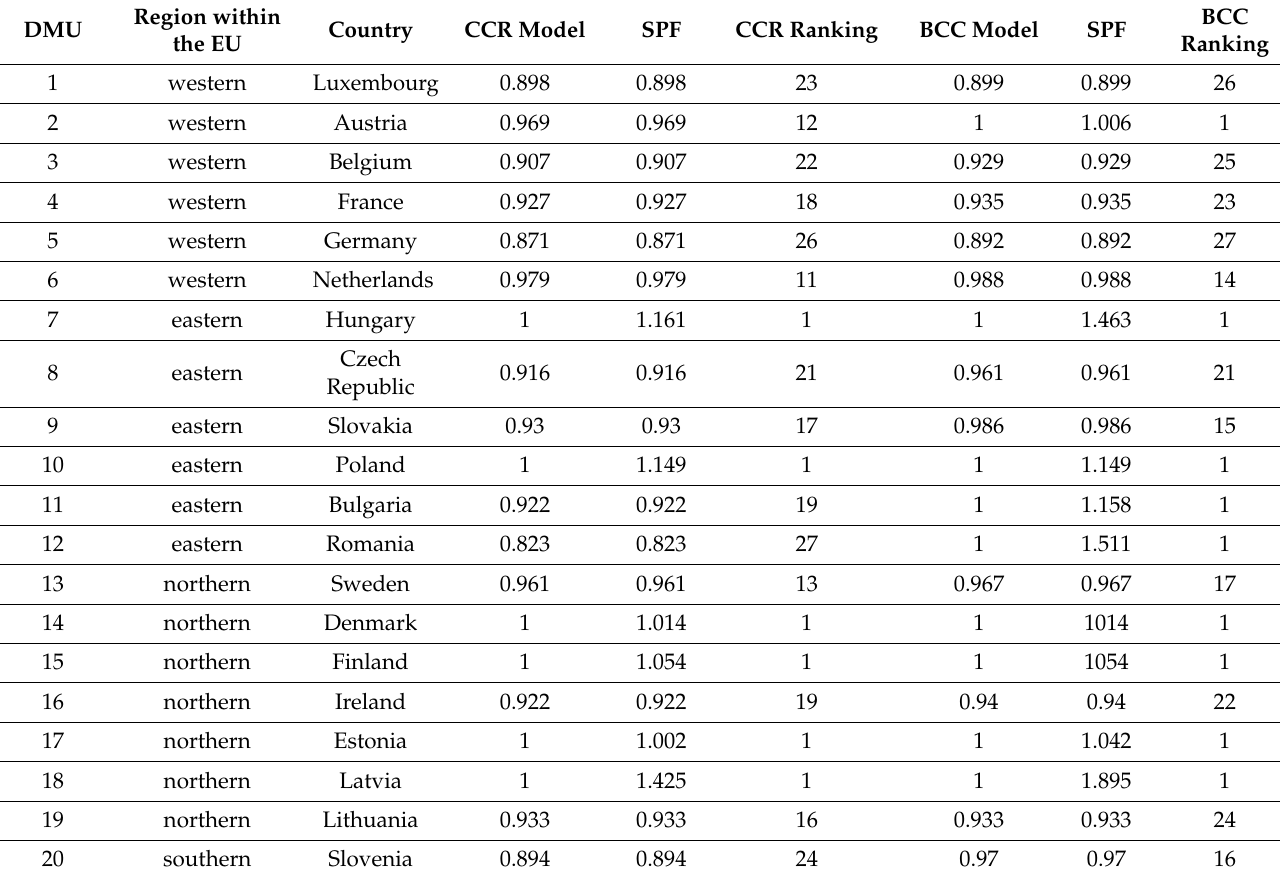
Table 12. Results of the DEA